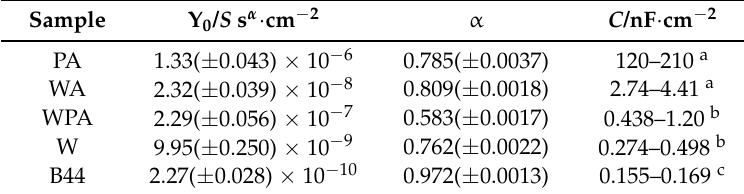
Table 3. High frequency CPE fit parameters and errors for the test panels and the associated capacitances calculated from equation 6 over a frequency range where the CPE dominated the circuit for each panel. The CPE parameter fitting errors are incorporated into the calculated capacitances, which are visualized in Figure